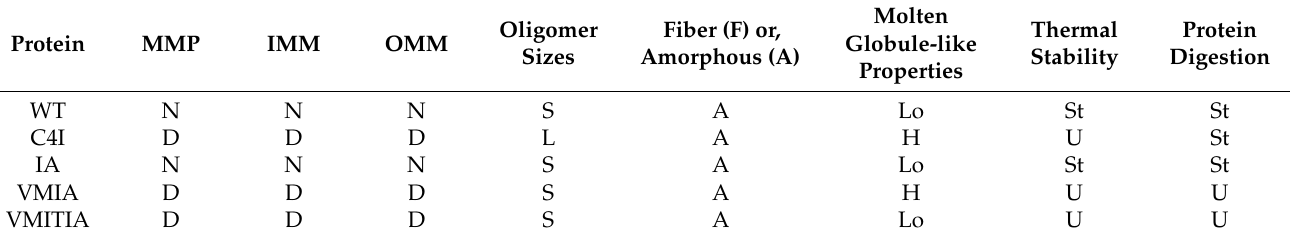
Table 2. Summary of the presented